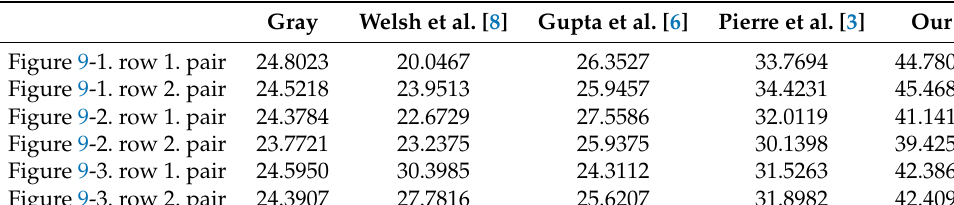
Figure 9-1. row 2. pair Figure 9-2. row 1. pair Figure 9-2. row 2. pair Figure 9-3. row 1. pair Figure 9-3. row 2. pair